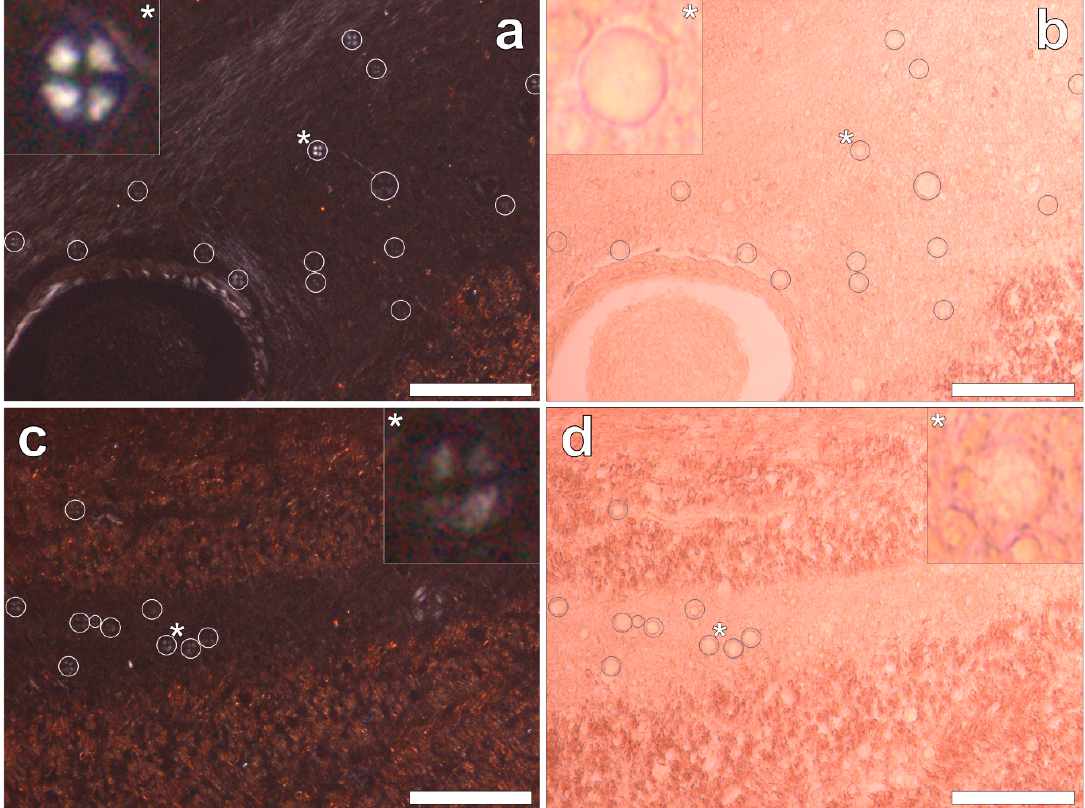
Figure 5. Congo red stained serial tissue sections of the occipital lobe, revealing multiple spherulites. Spherulites were noted via a Maltese-Cross diffraction pattern (white circles) under fully polarised light (a,c) and an ovoid-like morphology (grey circles) under bright field illumination (b,d). Spherulites were exclusively distributed across the grey-white matter interface of the occipital lobe. Magnification × 200, scale bars: 100 µm.